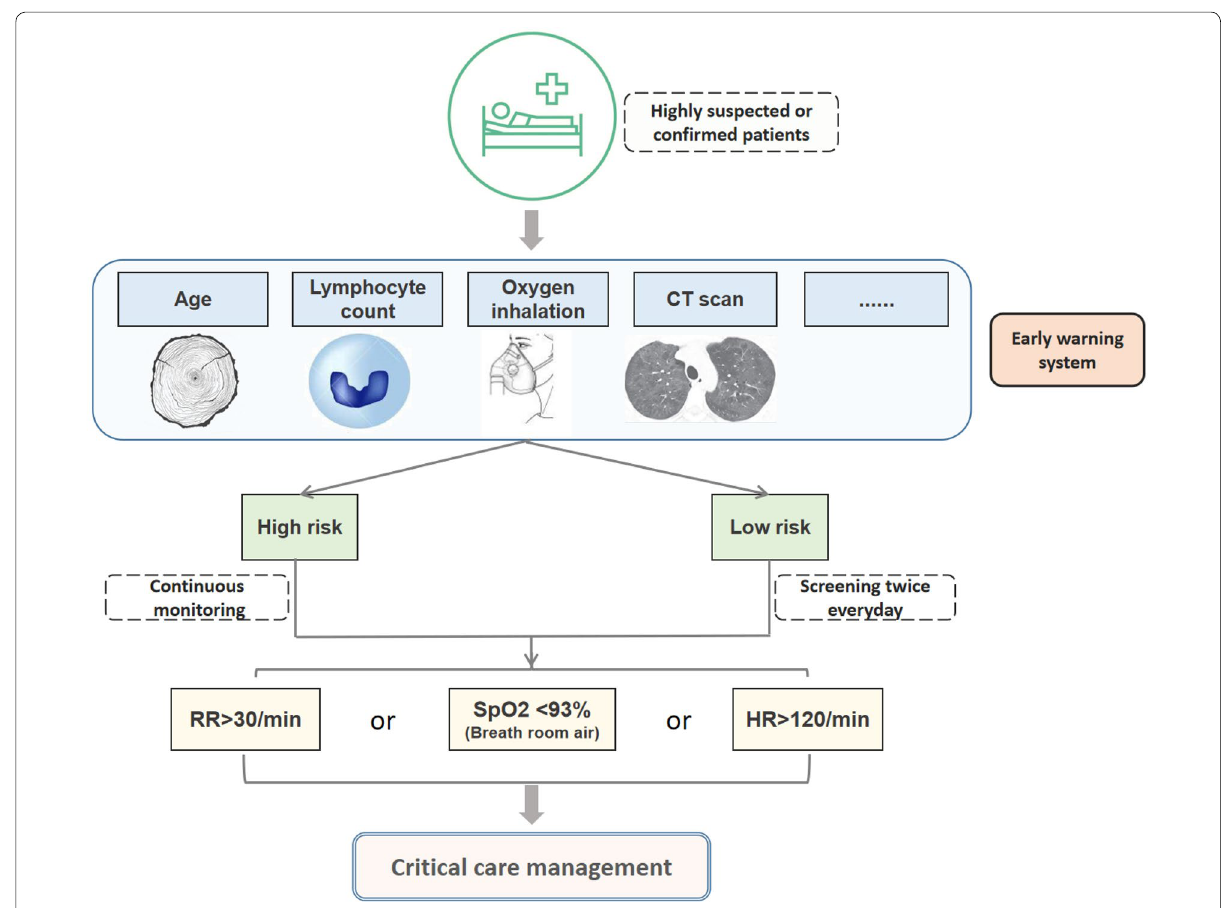
Fig. 1 Early warning system and screening procedures for NCP